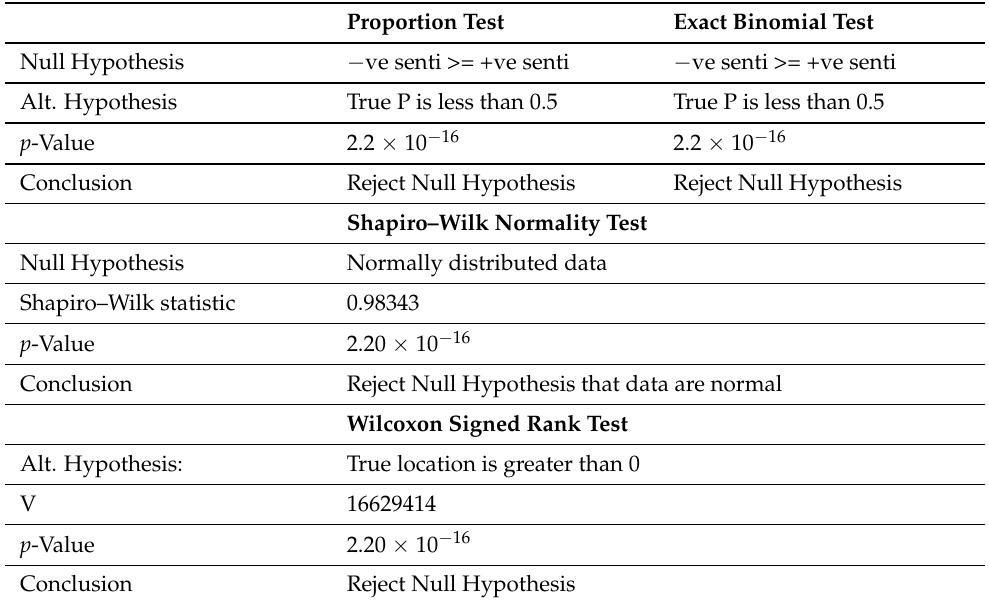
Table 3. Statistical tests for positive and negative sentiment counts for March 2021. ( a ) Proportion test for positive sentiment. ( b ) Shapiro–Wilk normality test for sentiment scores. ( c ) Wilcoxon signed rank test for mean of sentiment scores.